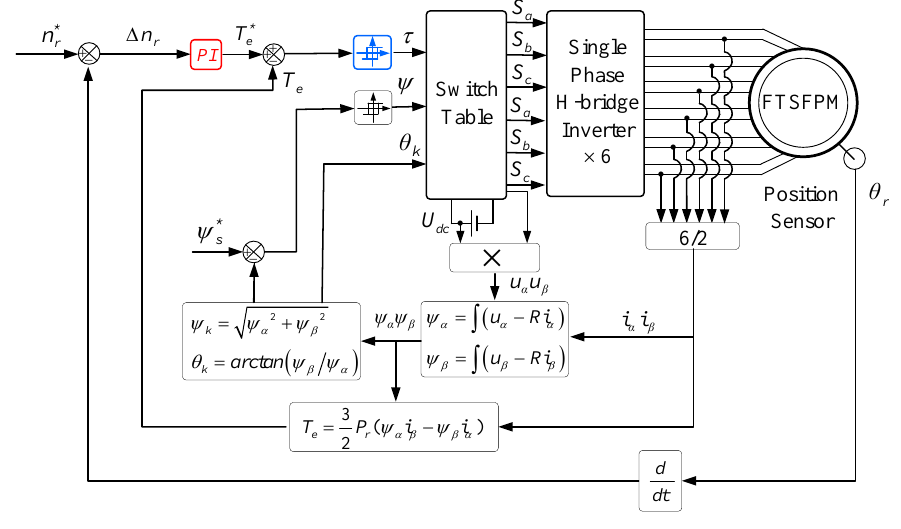
Figure 5. Diagram of the direct torque control.